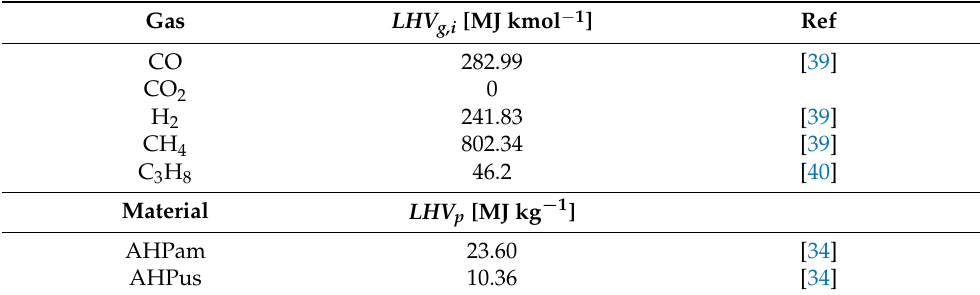
Table 2. Lower heating values of gas components ( LHV g,i ) and waste materials from AHP ( LHV p ), defined for Equation (4).